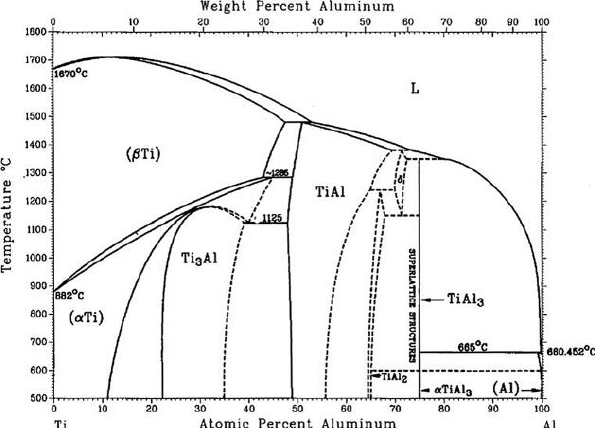
Figure 12. Al-Ti binary phase diagram.